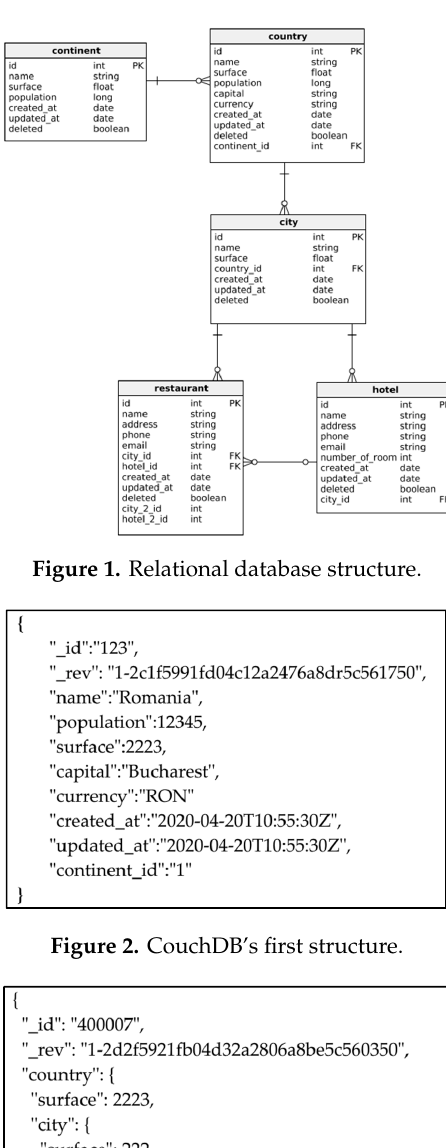
Figure 2. CouchDB’s first structure.